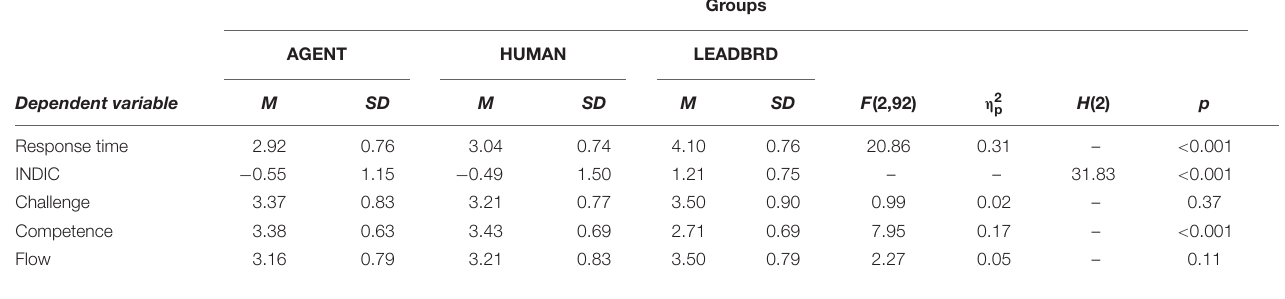
TABLE 6 | Response time, play behavior, and game experience within the